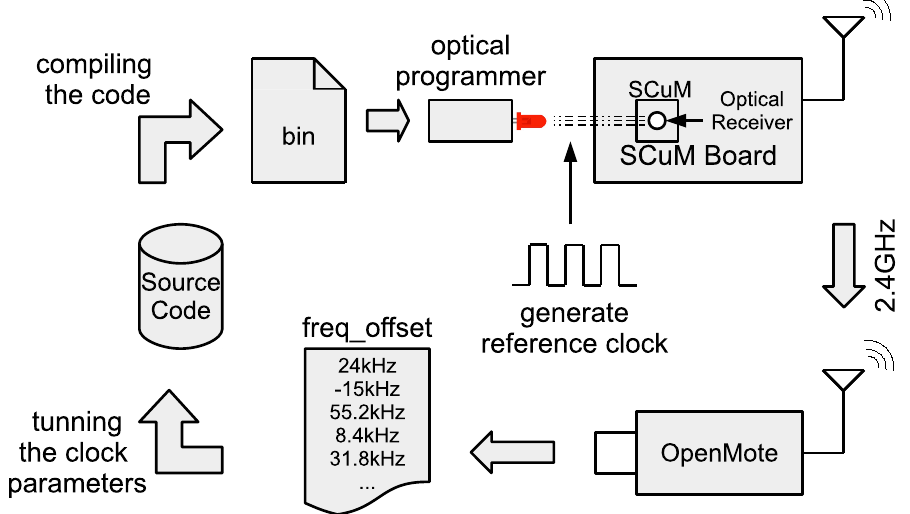
Figure 7. Setup used to tune the communication frequency of SCµM. SCµM transmits frames to